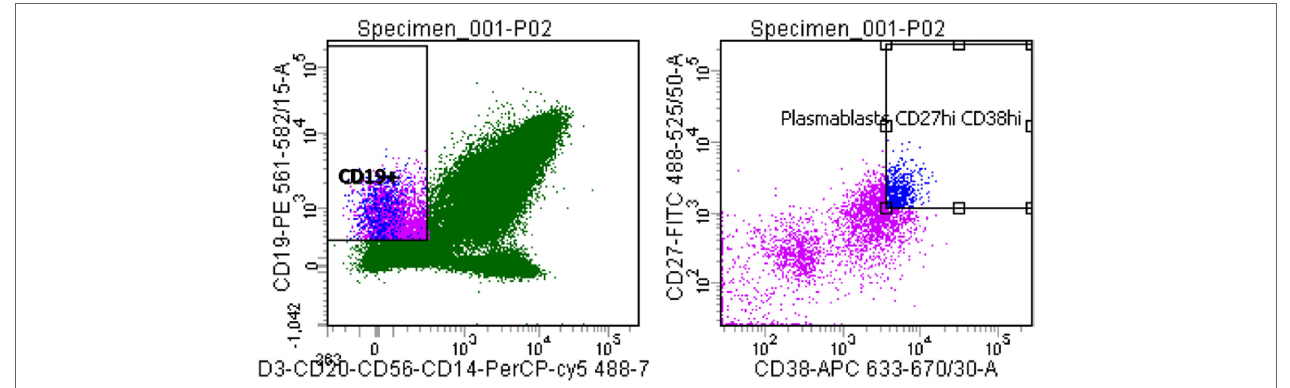
FigUre 1 | Quantitative analysis of patient SM-P02’s adaptive immune response to a MenB infection. Flow cytometry plots were gated for plasmablasts by CD3 − , CD19 + , then CD27 + /high and CD 38 + /high